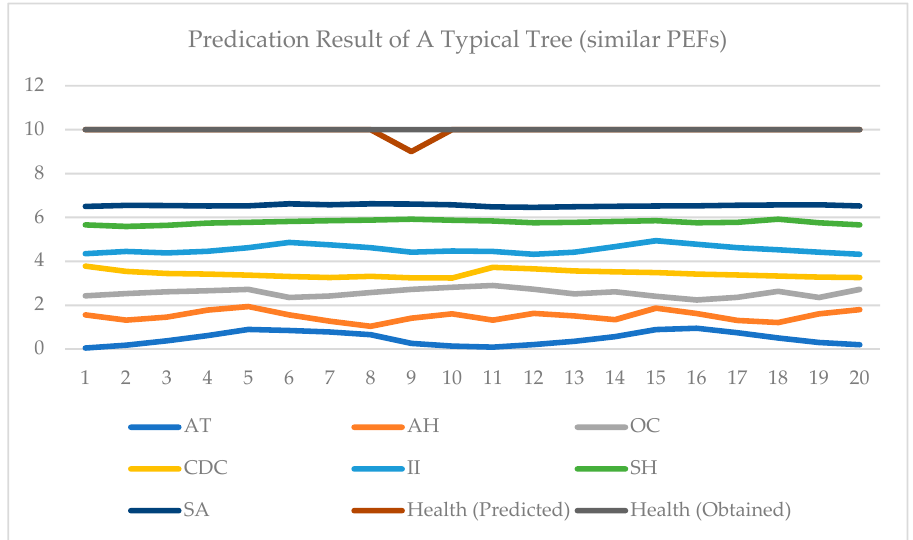
Figure 5. Prediction results of a typical tree (similar PEFs).